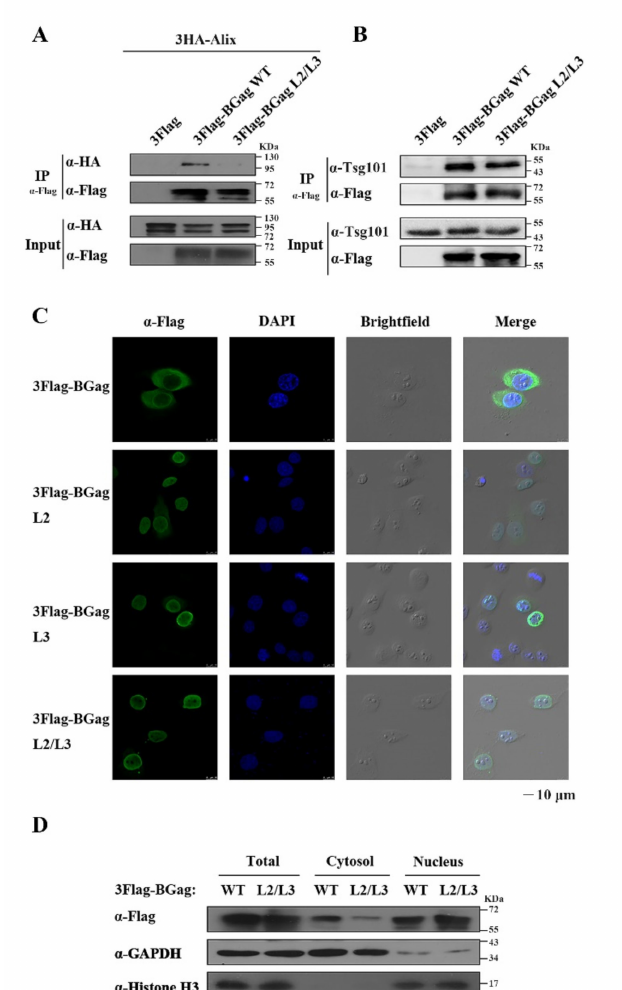
Figure 4. The localization of wild-type or L domain motifs-mutated BGag. ( A ) Immunoprecipitation with Flag antibody of HEK293T (4 × 10 6 ) cells co-transfected with eukaryotic expression plasmids encoding 3Flag-Gag or 3Flag-Gag L2/L3 and 3HA-Alix. ( B ) Immunoprecipitation with mouse anti-Flag antibody of HEK293T (4 × 10 6 ) cells transfected with eukaryotic expression plasmids encoding 3Flag-Gag or 3Flag-Gag L2/L3. The co-immunoprecipitated Tsg101 was detected using mouse anti-Tsg101 antibody, and the co-immunoprecipitated BGag protein was detected using mouse anti-Flag antibody. Tsg101 and BGag protein levels in the input were also detected using Tsg101 and Flag antibodies, respectively. ( C ) HeLa cells were transfected with 3Flag-BGag, 3Flag-BGag L2, 3Flag-BGag L3, or 3Flag-BGag L2/L3 (BFV Gag protein (BGag)). An indirect immunofluorescence assay (IFA) was used to localize wild-type or L domain motifs-mutated BGag (with mouse anti-Flag antibody and fluorescein isothiocyanate (FITC)-conjugated goat anti-mouse secondary antibody). Green represented the BGag protein, blue represented the nucleus, and brightfield showed the cell morphology. Scale bar = 10 µ m. ( D ) HEK293T cells were transfected with either 3Flag-Gag or 3Flag-Gag L2/L3. After 2 days, the cells were collected, and the nucleus and cytoplasmic components were separated. The BGag protein levels in the two components were determined using Western blotting. Histone 3 (H3) and glyceraldehyde-3-phosphate dehydrogenase (GAPDH) were used as nuclear and cytoplasmic markers,